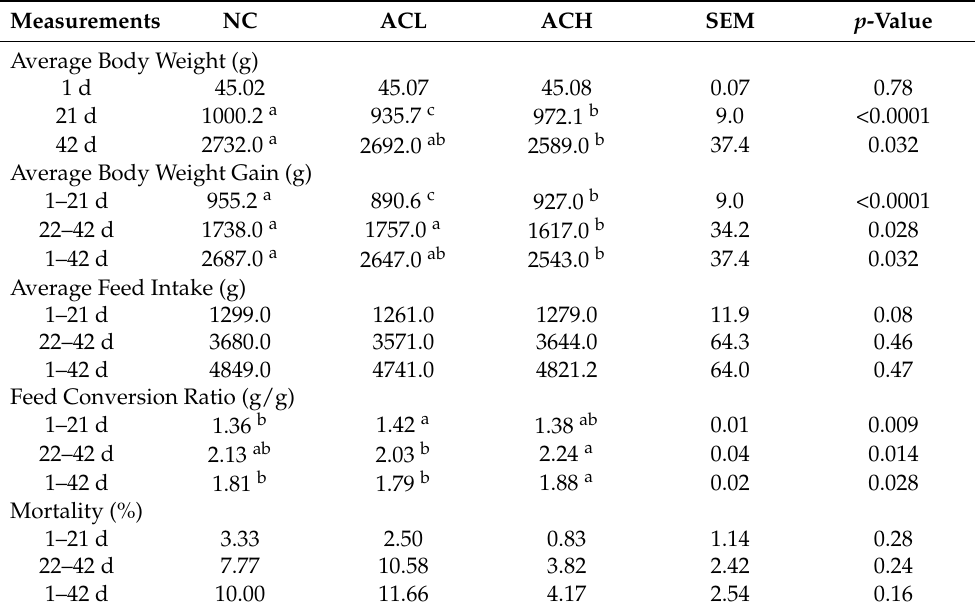
Table 4. Effect of different levels of aging corn on performance parameters under the three experi- mental diets 1 in broilers.